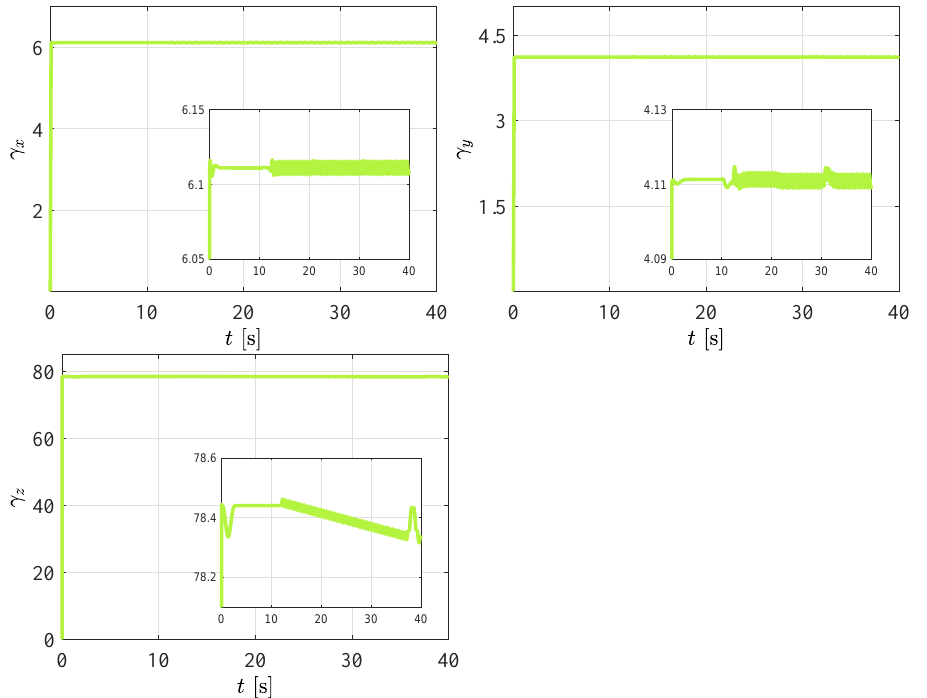
Figure 8. Adaptive γ i control parameters, for i = x , y , z